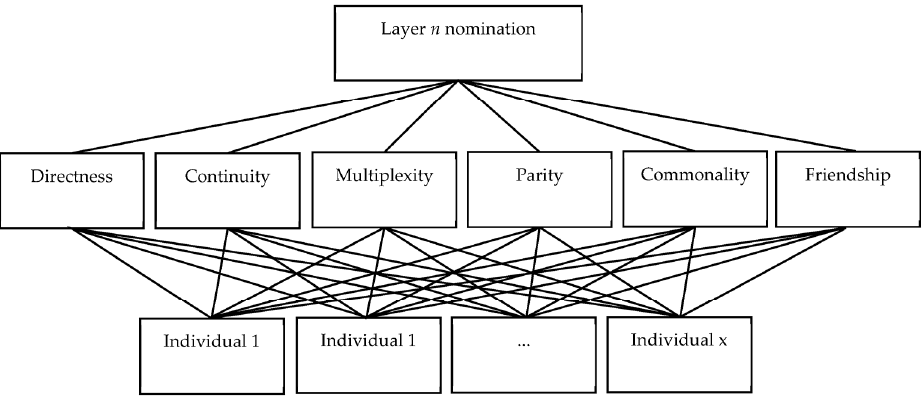
Figure 7. Multiple-criteria family